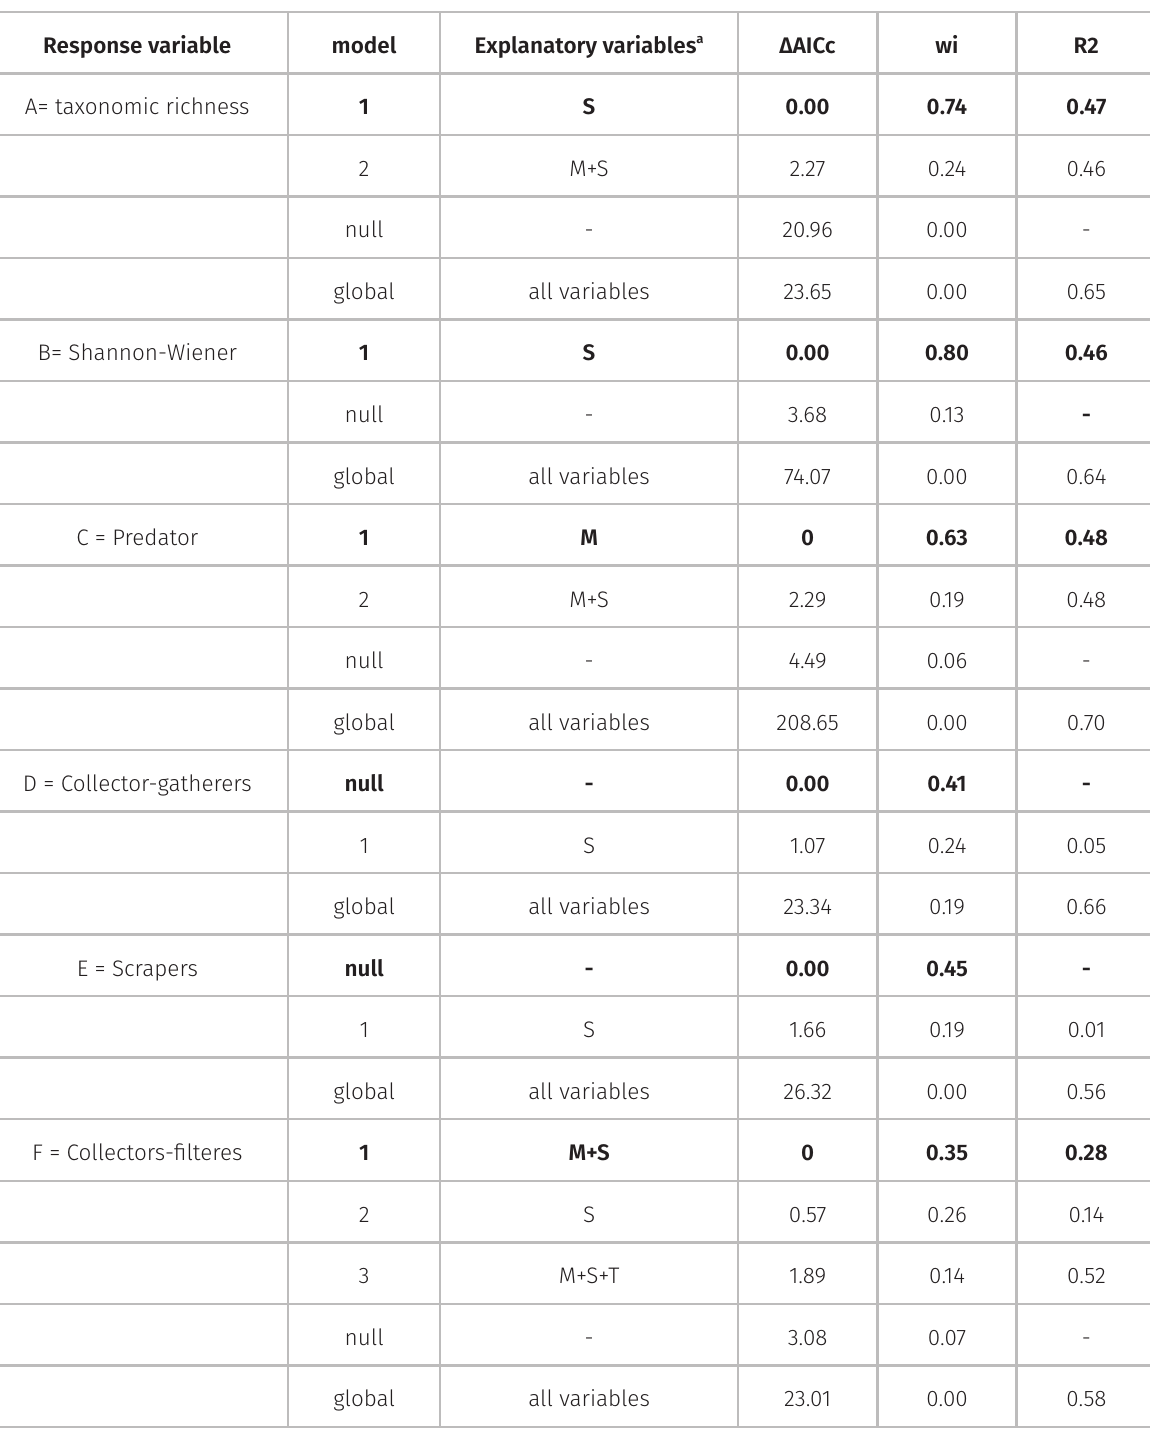
Table II. The linear models explaining variation in: A- taxonomic richness (GLM), B- Shannon-Wiener diversity (LM), C- predators (GLM), D-.gathering-collectors (GLM), E- Scrapers (GLM), F = filtering-collectors (GLM). The null model, the global model, and models with strong support (ΔAICc ≤2) are provided. Models are listed in decreasing order of importance. S = Site; M= macrophytes; T =